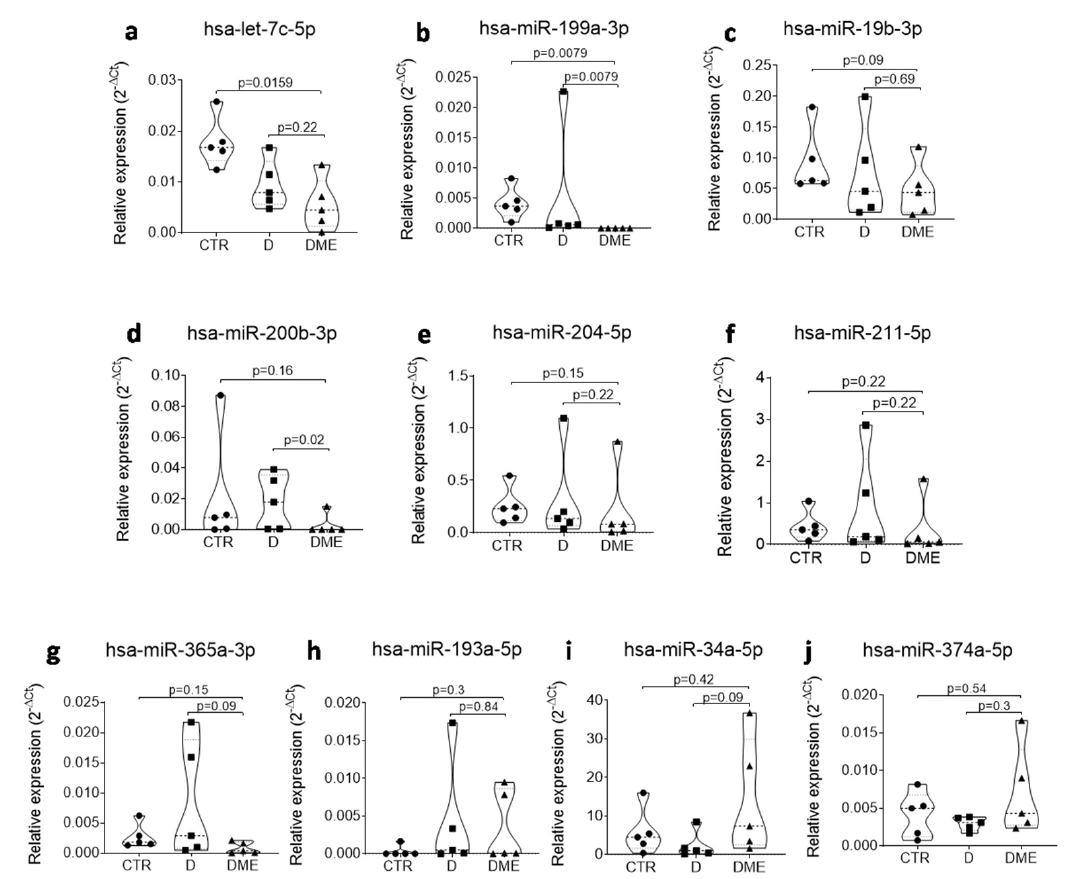
Figure 4. Single assay validation of n = 10 microRNAs that resulted deregulated in DME vs CTR and / or vs D in AH of the profiling cohort (5 patients per group) of DME vs CTR and vs D patients. Violin plots show the expression and the relative p values of hsa-let-7c-5p ( a ), hsa-miR-199a-3p ( b ), hsa-miR-19b-3p ( c ), hsa-miR-200b-3p ( d ), hsa-miR-204-5p ( e ), hsa-miR-211-5p ( f ), hsa-miR-365-3p ( g ), hsa-miR-193a-5p ( h ), hsa-miR-34a-5p ( i ) and hsa-miR-374a-5p ( j ). miRNA expression values are reported as 2 − ∆ CT normalized for the expression of hsa-miR-150-5p. Median values for each group are shown as dotted line alongside with quartiles (smaller dotted lines). p -values were considered significant with p < 0.05 using Mann–Whitney U Test.